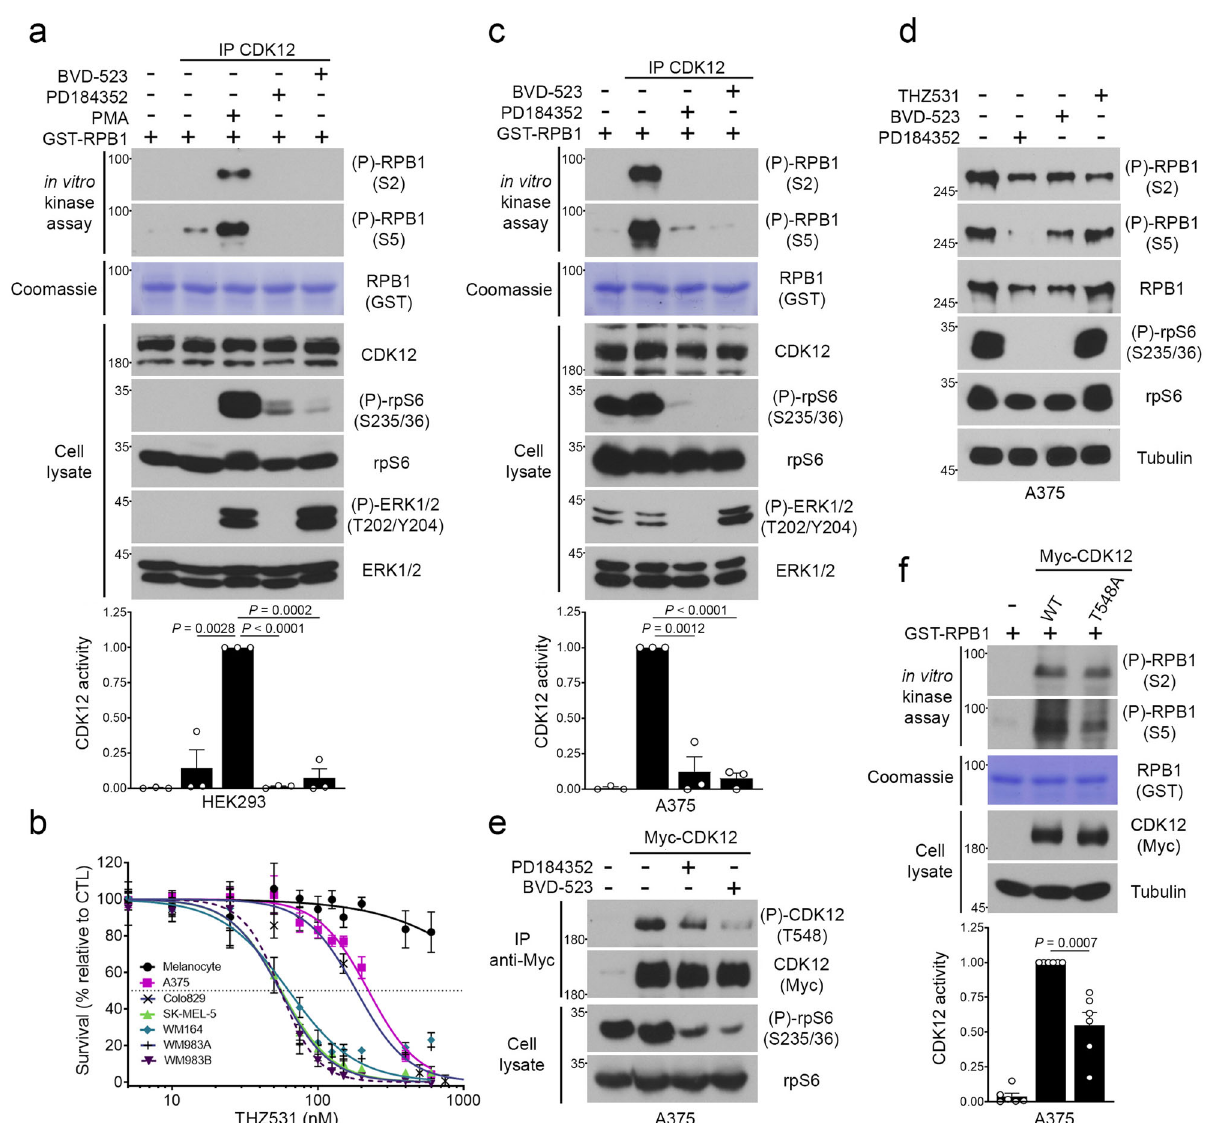
Fig. 3 | ERK1/2 promote CDK12 activation in BRAF-mutated melanoma cells. a In vitro kinase assay based on endogenous CDK12 immunoprecipitated from HEK293cells.Cellswereserum-starvedovernight,andtreatedwithBVD-523(2 µ M) or PD184352 (10 µ M) for 30min before PMA stimulation (100ng/ml) for another 30min. Total cell lysates were immunoblotted with speci fi c antibodies. For kinase reactions,recombinantGST-RPB1wasdetectedbyCoomassiestainingandsamples were immunoblotted with speci fi c RPB1 phospho-Ser2/Ser5 antibodies. CDK12 kinaseactivitywasquanti fi edusingSer2phosphorylationasoutput. b